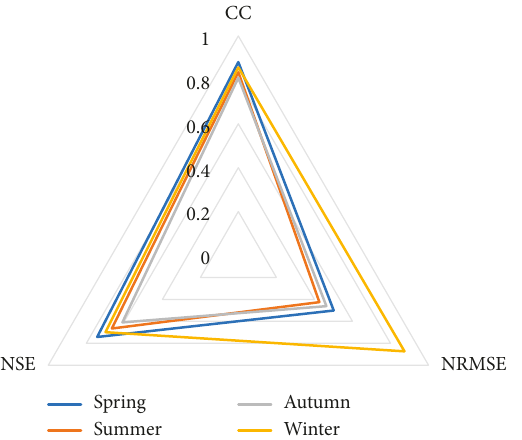
Figure 5: Numerical values of CC, NRMSE, and NSE at the seasonal scale.